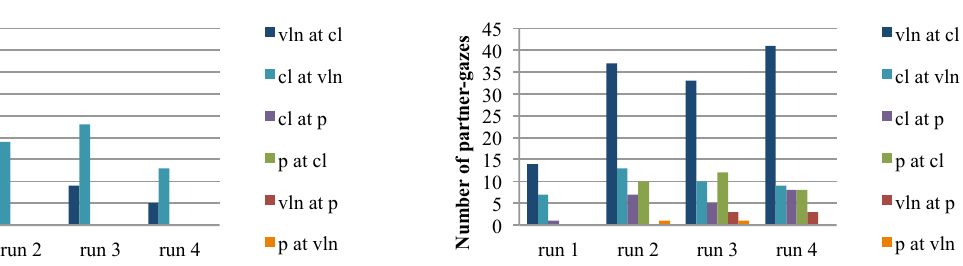
Figure 3. Number of partner-gazes across run-throughs. Partner-gazes take place from violin to clarinet (vln at cl), from clarinet to violin (cl at vln), from clarinet to piano (cl at p), from piano to clarinet (p at cl), from violin to piano (vln at p), and from piano to violin (p at